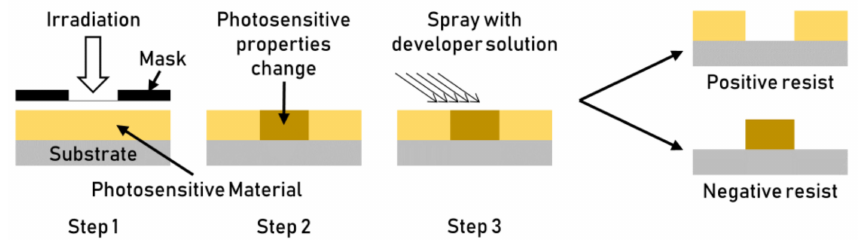
Figure 11. Working principle for lithography